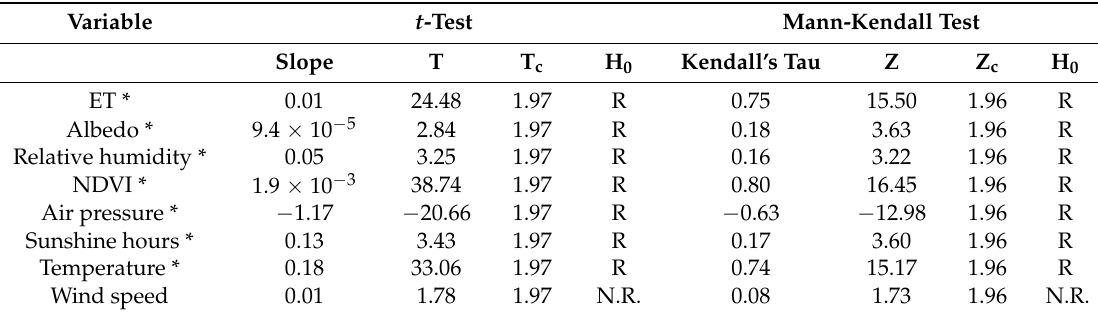
Table 2. Trend tests for ET and other parameters.